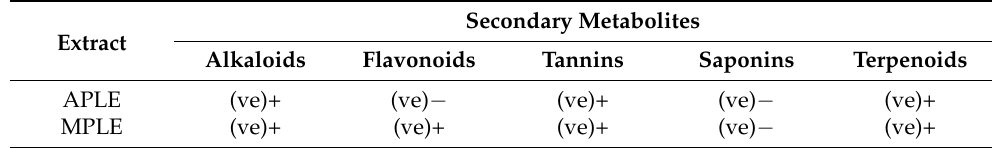
Figure 1. ( A ) Aqueous patchouli leaves extract (APLE) and methanolic patchouli leaves extract (MPLE); ( B ) High fraction of patchouli oil (HFoPO) and light fraction of patchouli oil (LFoPO); ( C ) sil- ver nanoparticles synthesized in methanolic of patchouli leave extract (AgAENPs); and ( D ) silver nanoparticles synthesized in aqueous of patchouli leave extract (AgMENPs). Table 1. Phytochemicals Aqueous patchouli leaf extract (APLE) and methanolic patchouli leaf extract (MPLE)